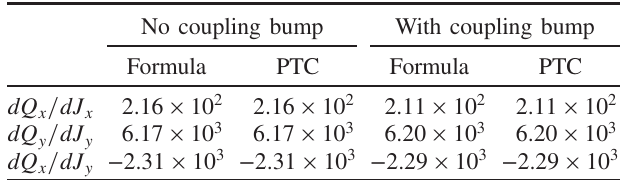
TABLE II. Amplitude detuning from a single octupole outside of the coupling bump in arc 23.